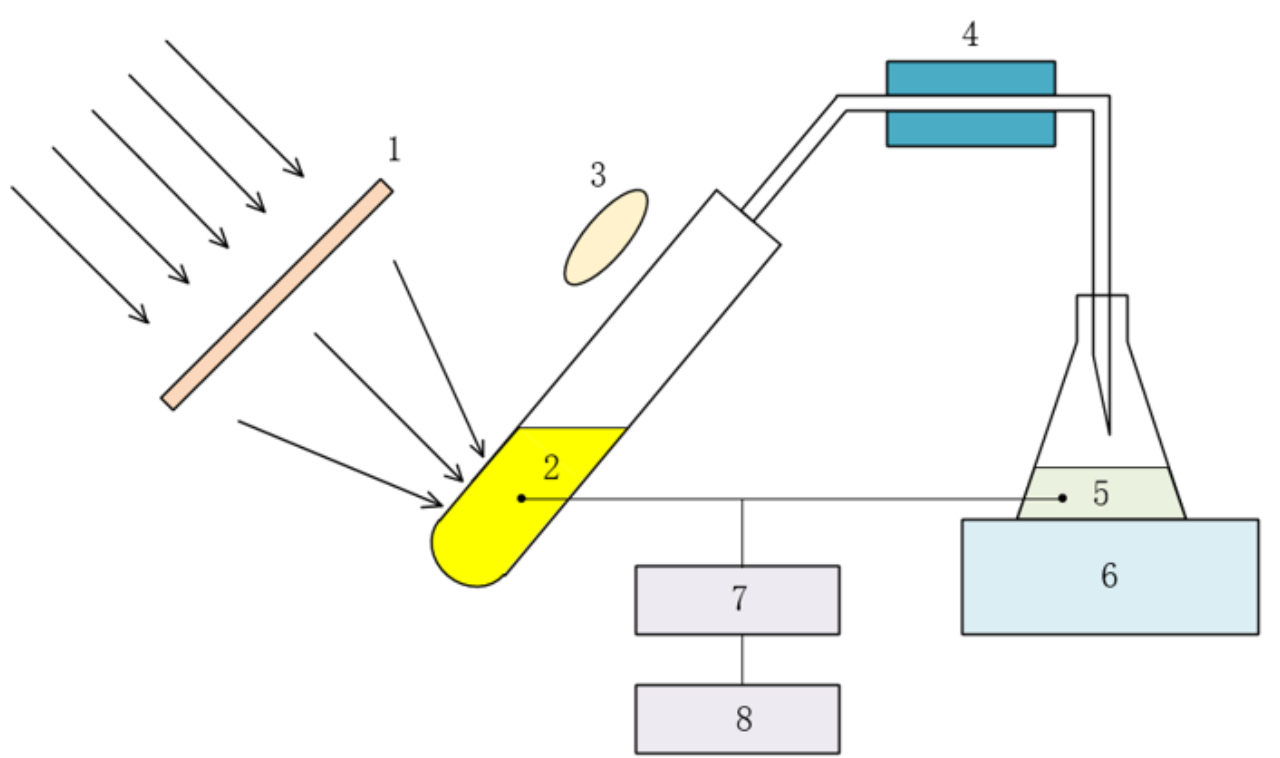
Figure 5. Experimental setup for migration characteristics of nanoparticles. 1. Fresnel lens. 2. Nanofluids. 3. Solar radiation meter. 4. Condenser. 5. Condensed nanofluids. 6. Balance. 7. UV spectrophotometer. 8. Computer.